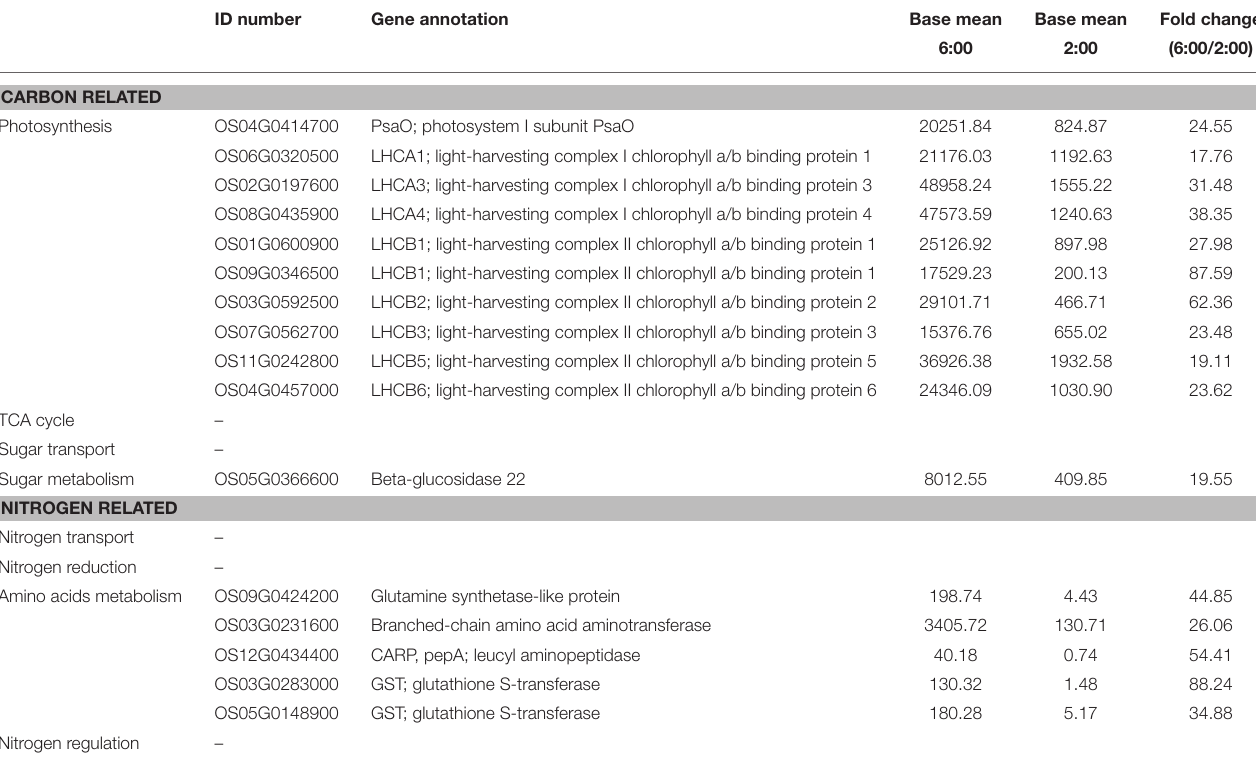
TABLE 1 | Differentially expressed genes involved in carbon and nitrogen metabolism at the time of 6:00 compared to 2:00. ID